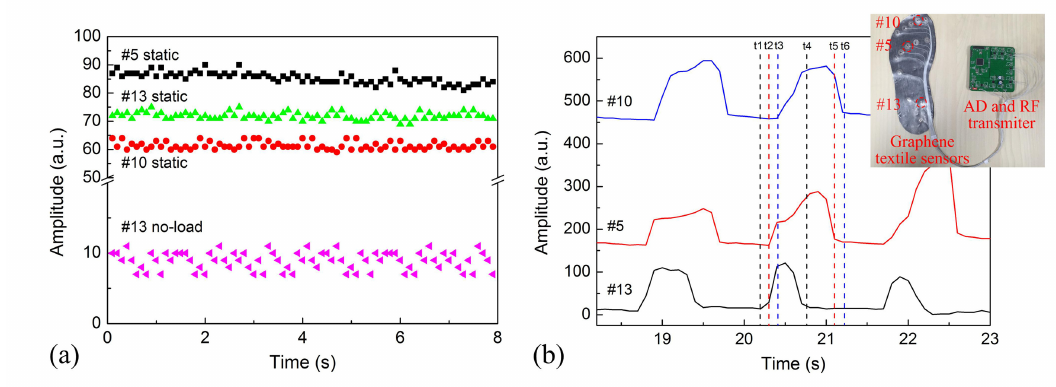
Figure 7. ( a ) The pressure amplitude of 3 sensors in the static standing state. ( b ) A stride of raw signals measured from right foot of an able-bodied